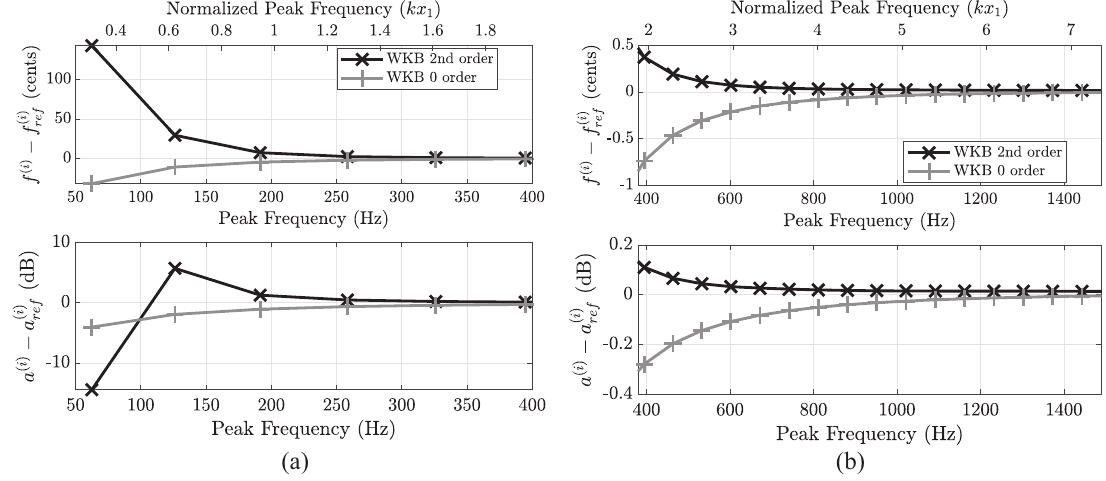
Figure 6. Difference between the resonance parameters of the WKB simulations (second and zeroth order) to those of the reference impedance: top : frequencies and bottom : magnitudes. (a) Low frequencies and (b) high frequencies (the vertical scales are different). In both WKB solutions, the second order approximation is used for the visco-thermal